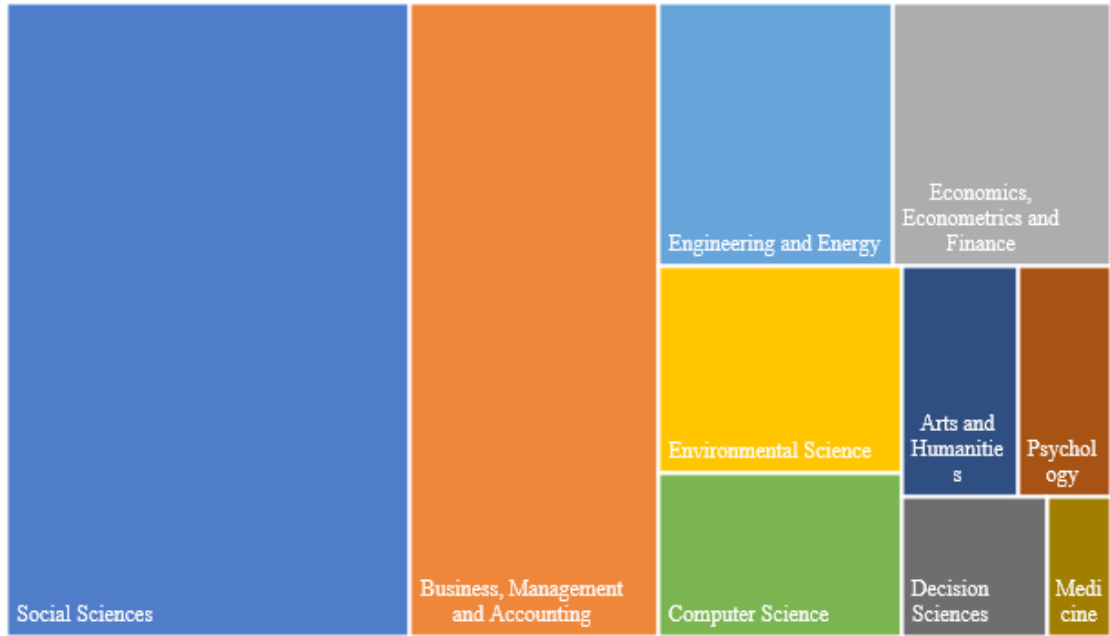
Figure 2. Analysis of publications on the third role of the university by subject area in the Scopus database for